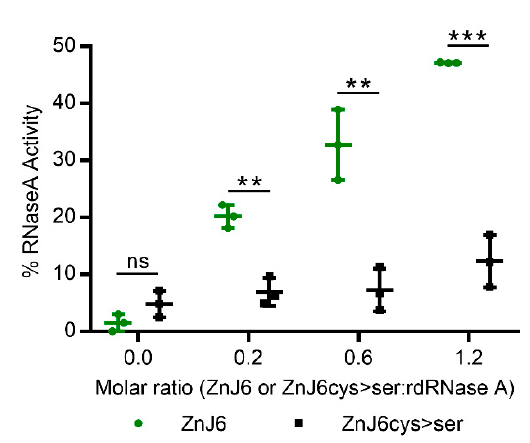
Figure 6. ZnJ6 affects the reactivation of reduced and denatured RNaseA. Reactivation of reduced and denatured RNaseA (rdRNaseA) generated using guanidinium hydrochloride (GnHCl) and dithiothreitol (DTT) was initiated 200-fold dilution into renaturation buffer to a final concentration of 25 µg/mL. Reactivation was conducted with and without ZnJ6, which was added at molar ratios of 0:1, 0.2:1, 0.6:1, and 1.2:1 relative to rdRNaseA. Reactivation was monitored in the presence of the WT ZnJ6 (green circles), or its ZnJ6cys > Ser-mutant (black squares). Aliquots were removed at various intervals and transferred into the assay mixture, and RNaseA activity was measured by monitoring the hydrolysis of cytidine 2 (cid:48) 3 (cid:48) -cyclic monophosphate at 284 nm. The points represent the final percentage of RNaseA activity compared to the native RNaseA after 1 h of reactivation. Presented values are mean of triplicates, t -test was used for analysis, and the error bars show standard deviations (*** and **: p values ≤ 0. 001, and 0.01, respectively, ns: not